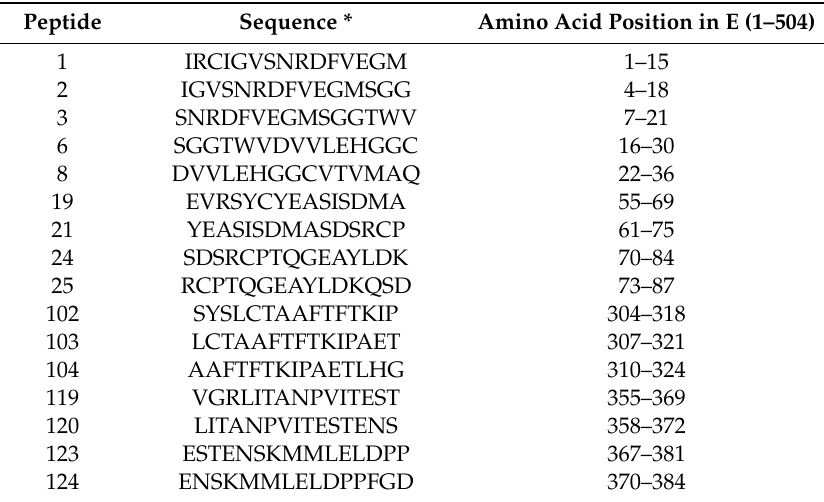
Table 2. Peptides used for stimulation of T